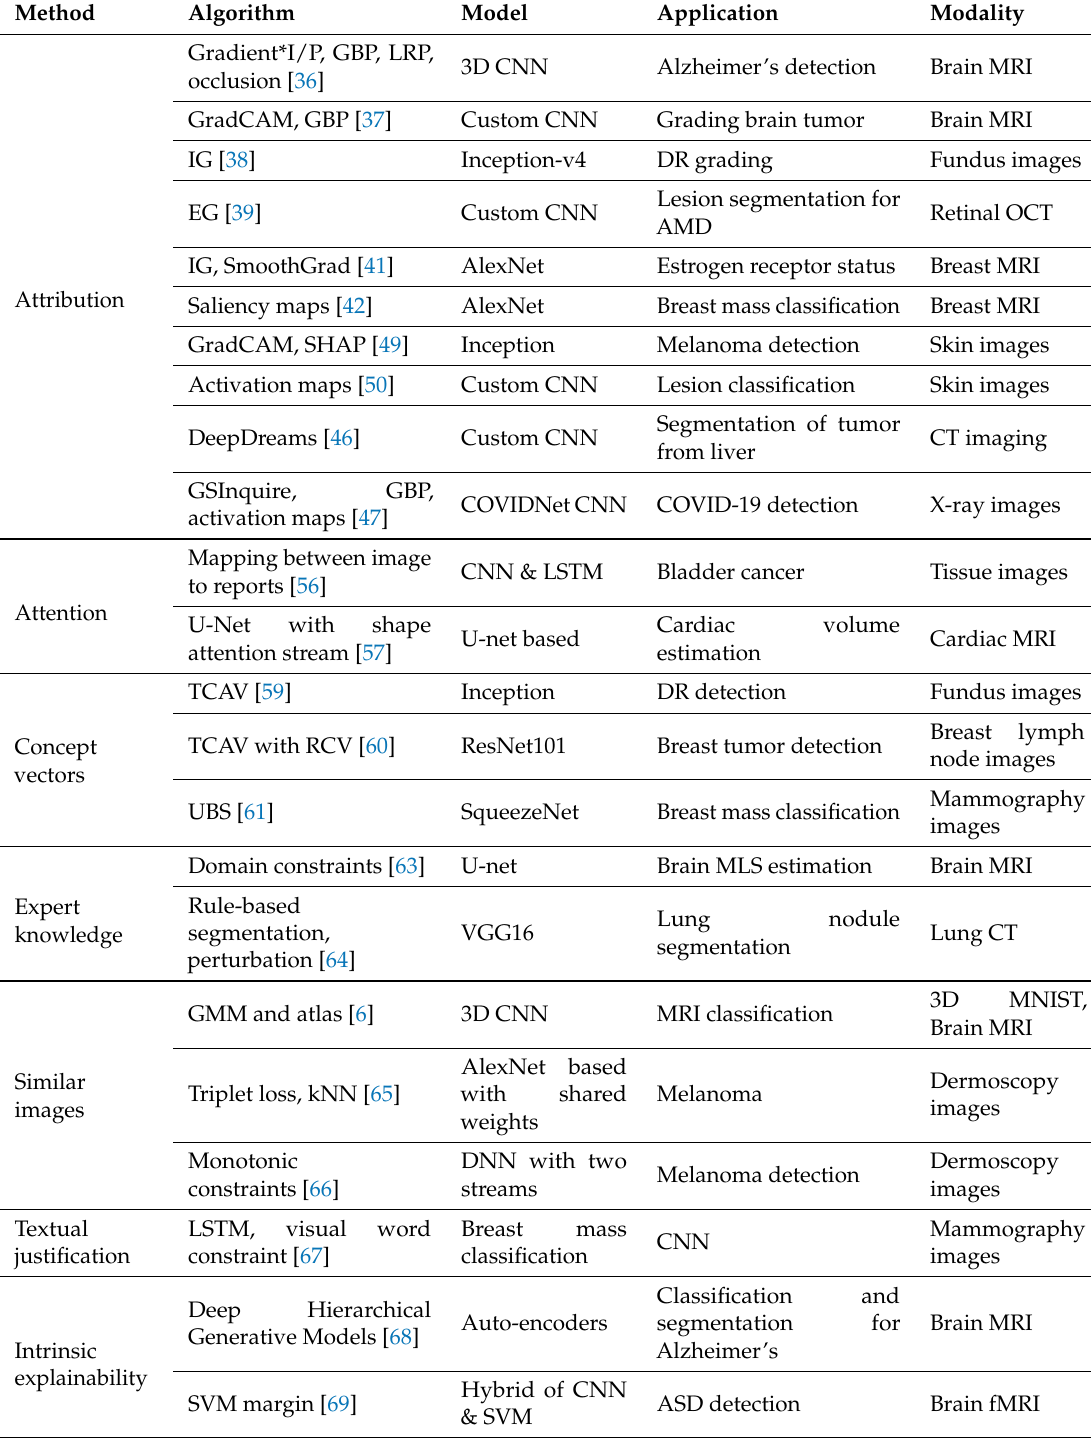
Table 2. Applications of explainability in medical